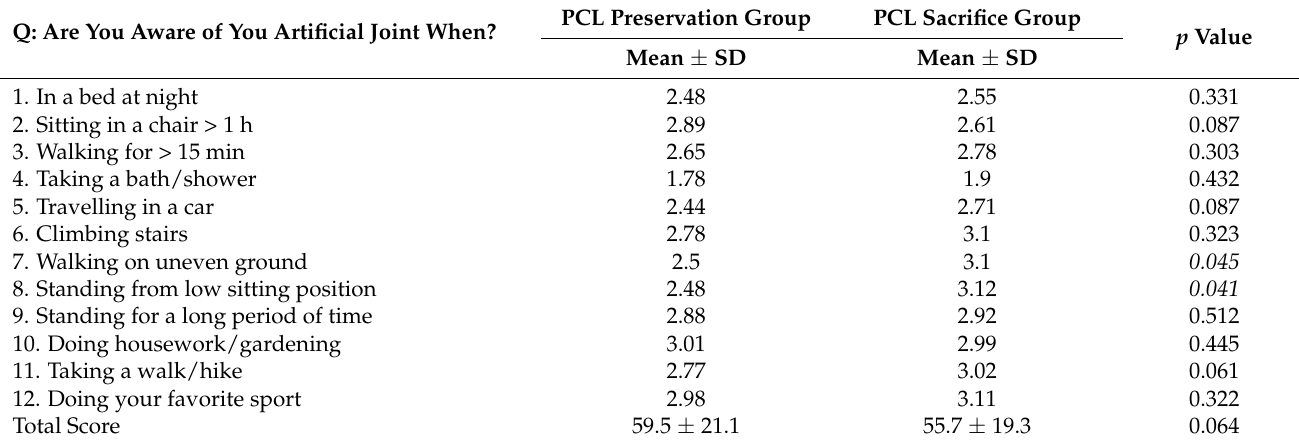
Table 4. Forgotten Joint Score applied to patients included in the present